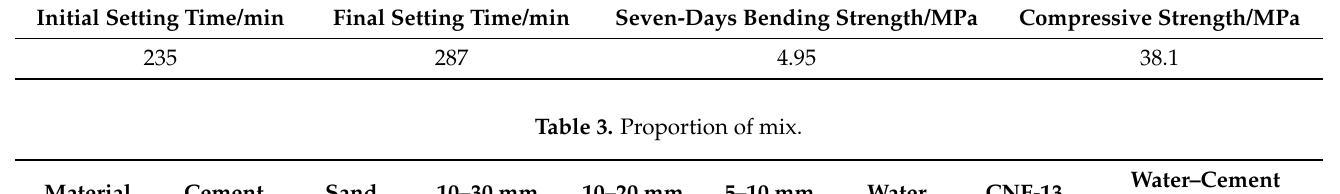
Table 2. Cement parameters. Table 3. Proportion of mix.